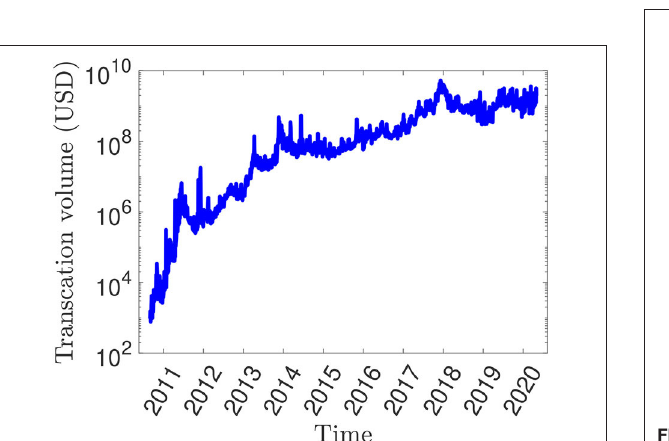
FIGURE 5 | Daily transaction volume V t reported in USD.